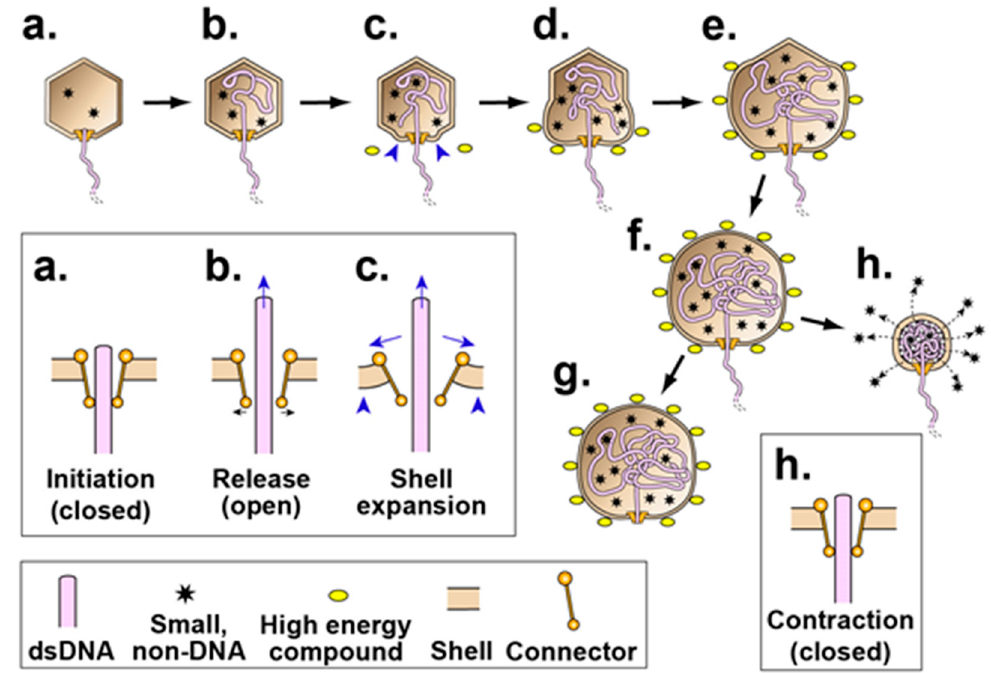
Figure 2. A version of the type 2 cycle, as proposed in reference 2 to exist before evolution of terminases. The legend at the bottom indicates the representation of a double stranded DNA (dsDNA) molecule, high-energy compound, packaged non-DNA molecule and capsid proteins. The insets (enclosed by rectangles) show the connector region of the corresponding capsid at higher magnification. ( a , b ) After initiation, opening of the connector releases the DNA molecule and ( c ) initiates shell expansion; ( d – f ) shell expansion is progressively driven by binding the high-energy compound, ATP ( yellow ovals with dark rim ). This binding is accompanied by shell permeability decrease to minimize packaging of non-DNA molecules. A source of the driving force for packaging is an osmotic pressure gradient across the shell produced by the shell expansion, coupled with impermeability of the shell to molecules in the bacterial cytoplasm. Relatively early in evolutionary time, the process of ( a – f ) ends with ( g ) external DNA subsequently digested. Subsequently, by this hypothesis, packaging evolves to be cyclic via ( h ) contraction of the shell, accompanied by opening of holes in the shell and expulsion of non-DNA molecules (stars) through these holes. In a new cycle, ( a – f , h ) repeat.